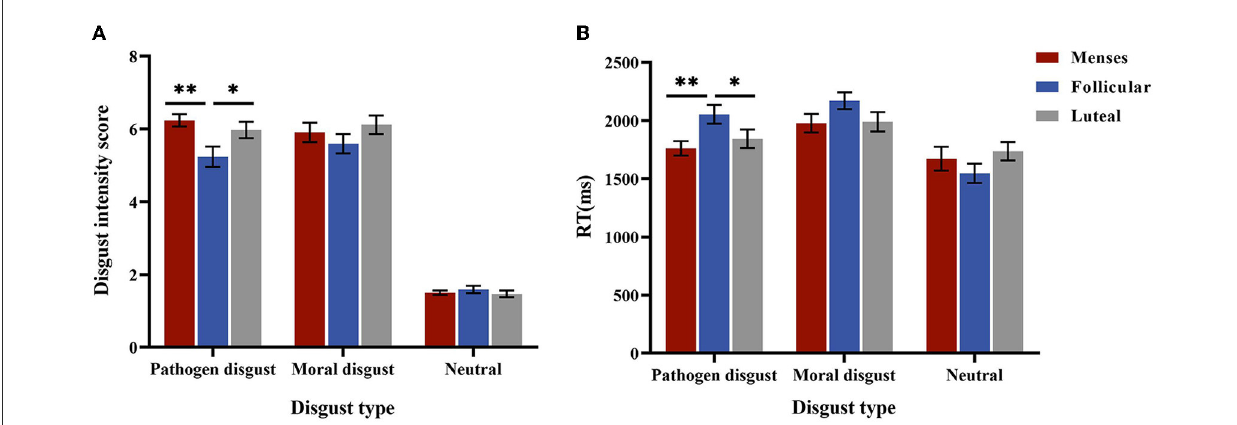
FIGURE3 Performances in the explicit intensity score. (A) is the disgust intensity score for women as a function of disgust type * cycle phase in low-intensity stimulus. (B) is the mean RTs for women as a function of disgust type * cycle phase. Error bars represent the standard error of the mean. ** p < 0.01; * p <